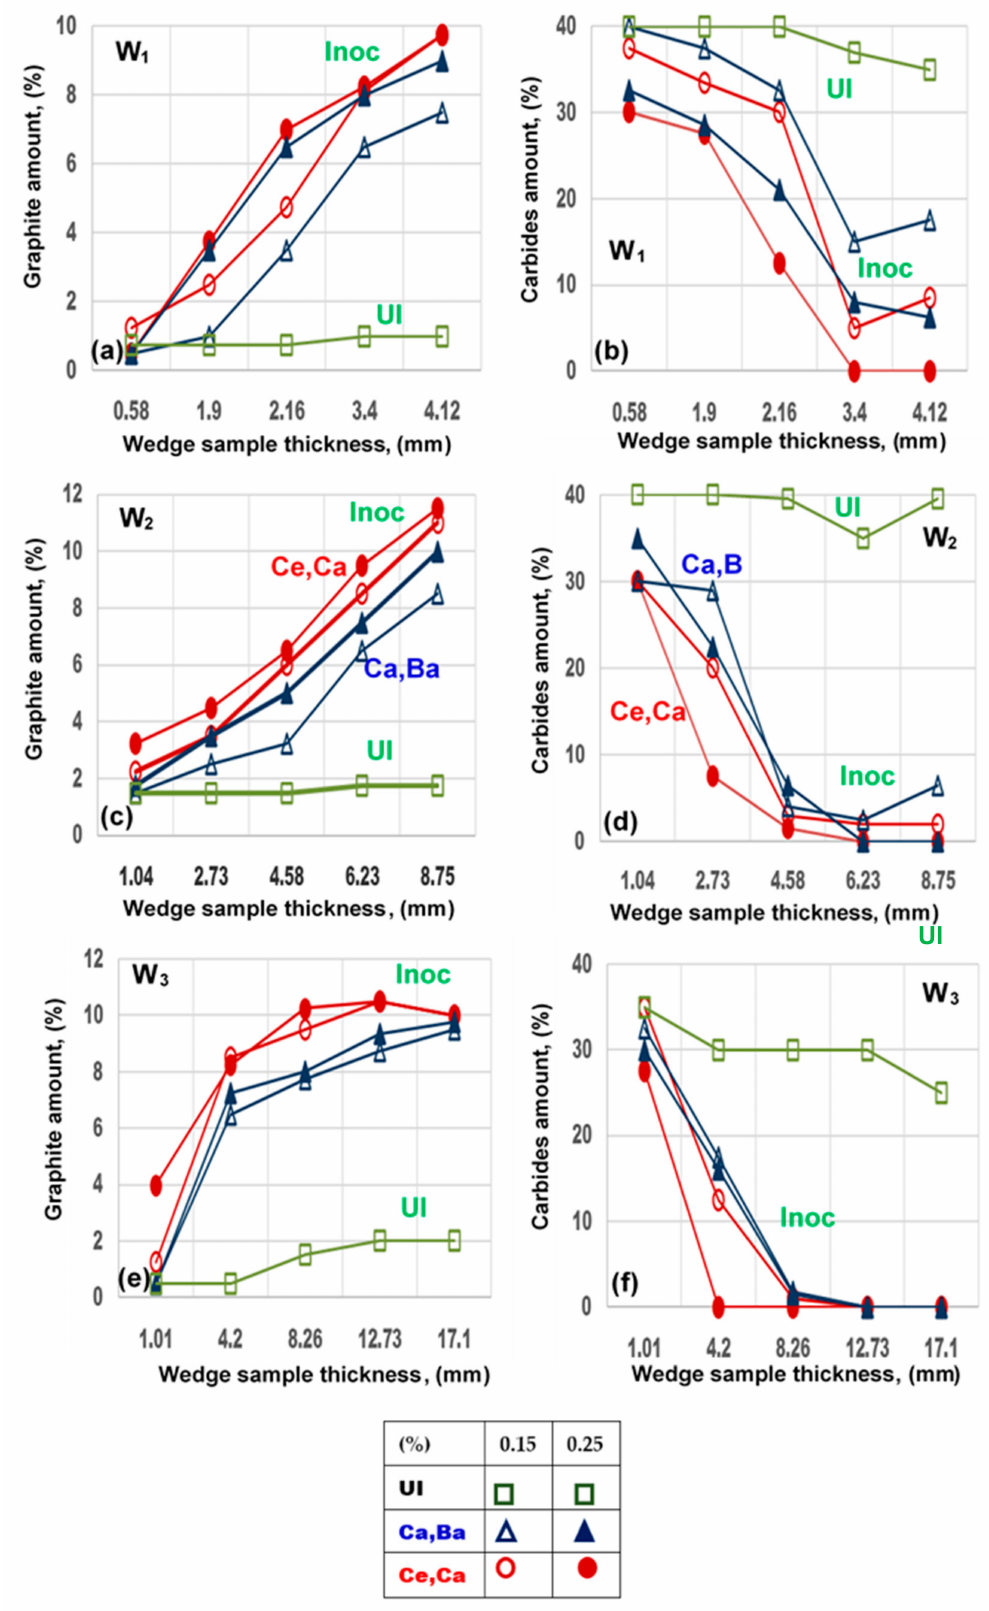
Figure 7. Influence of thickness of wedge samples W 1 ( a , b ), W 2 ( c , d ) and W 3 ( e , f ) on the graphite amount ( a , c , e ) and carbides amount ( b , d , f ) (UI/Inoc—un-inoculated/inoculated (Ca,Ba/Ce,Ca) grey cast